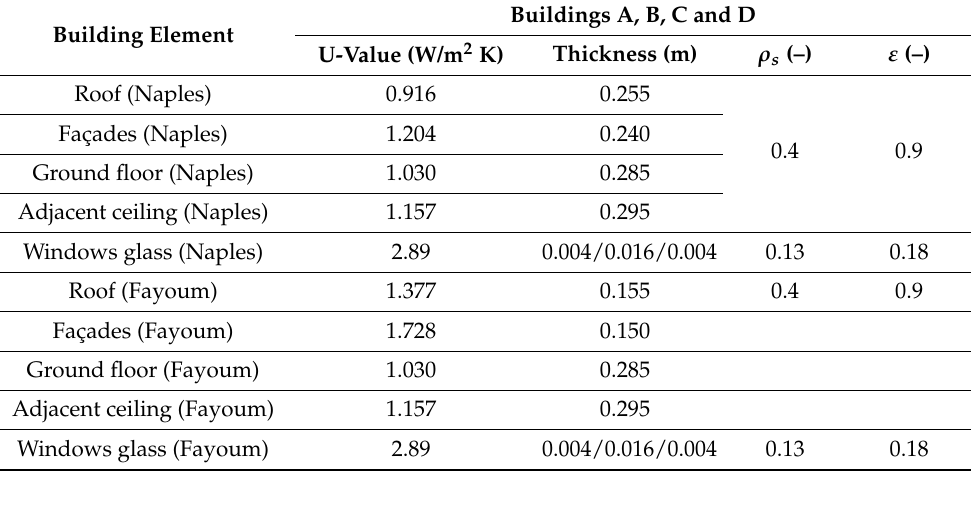
Table 4. Envelope features for each building.